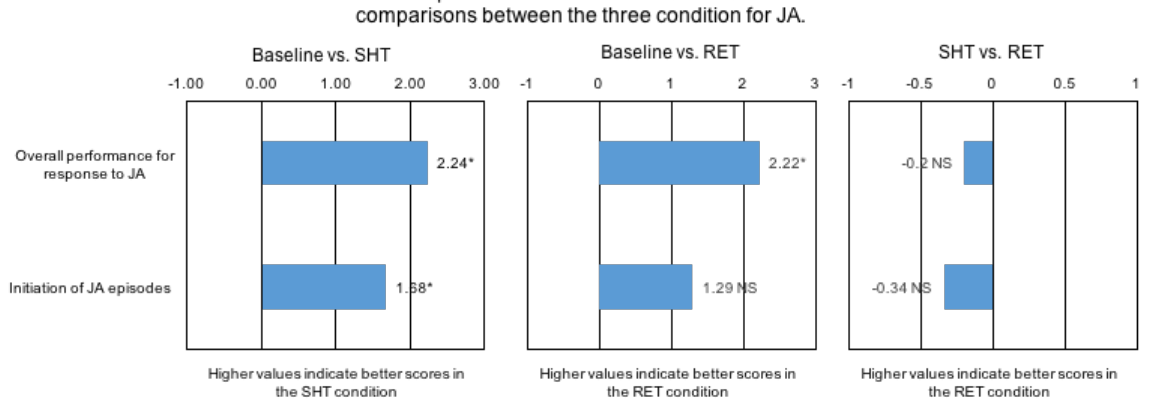
Figure 2: Cohen’s d effect sizes for each comparison between the baseline, RET and SHT conditions. “*” indicates a statistically significant difference. “NS” indicates a comparison that is not statistically